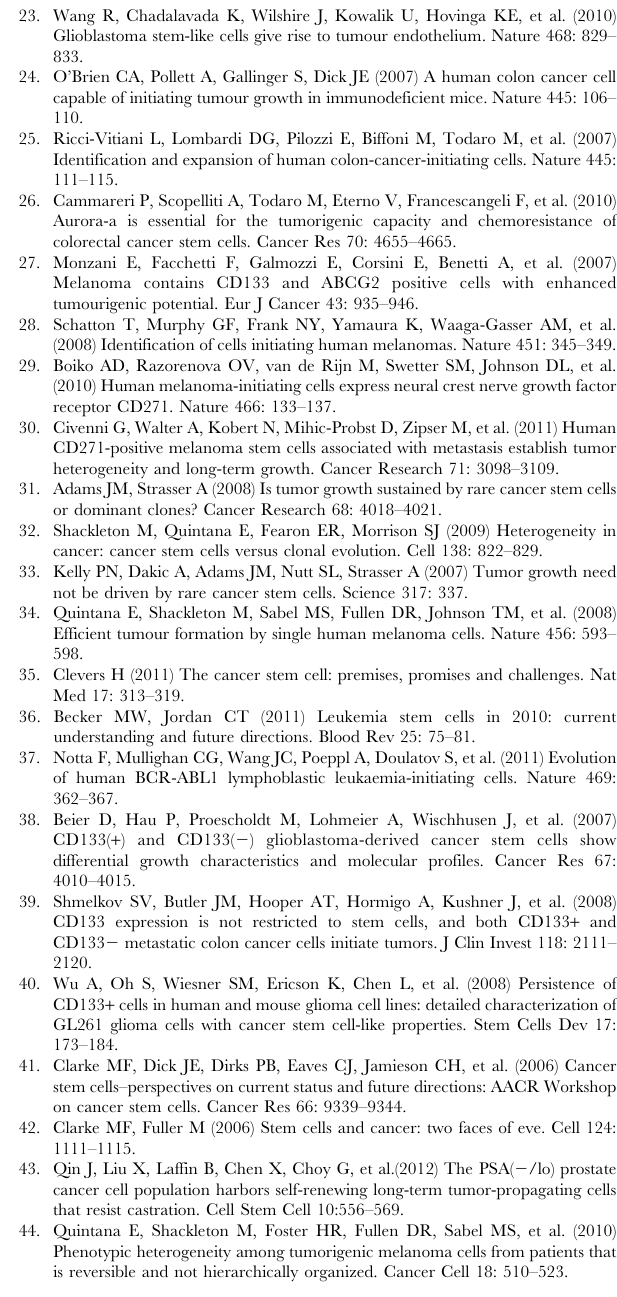
Experimental Procedures for details). Then, the percent of CSC- positive cells in CSC + -(DsRed-labeled) and CSC 2 -derived (EGFP- labeled) population was analyzed by flow